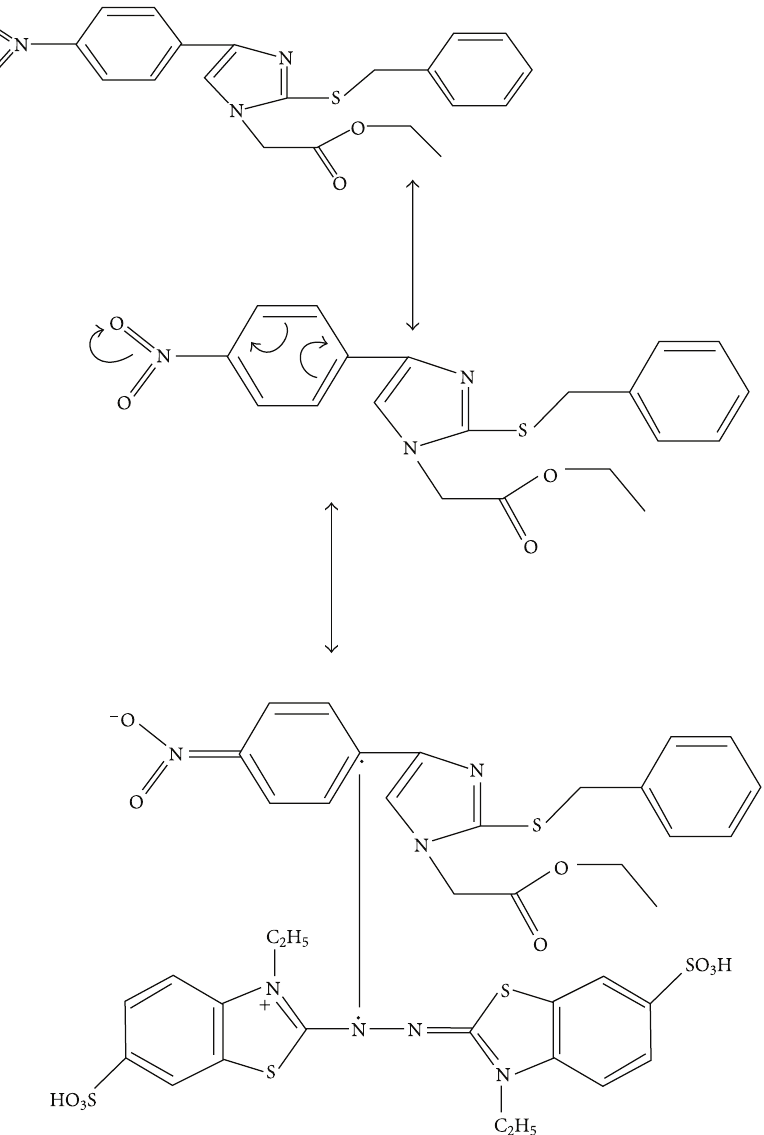
Figure 4: First suggested mechanism for the antioxidant activity of active ingredient separated from E. compressa against ABTS